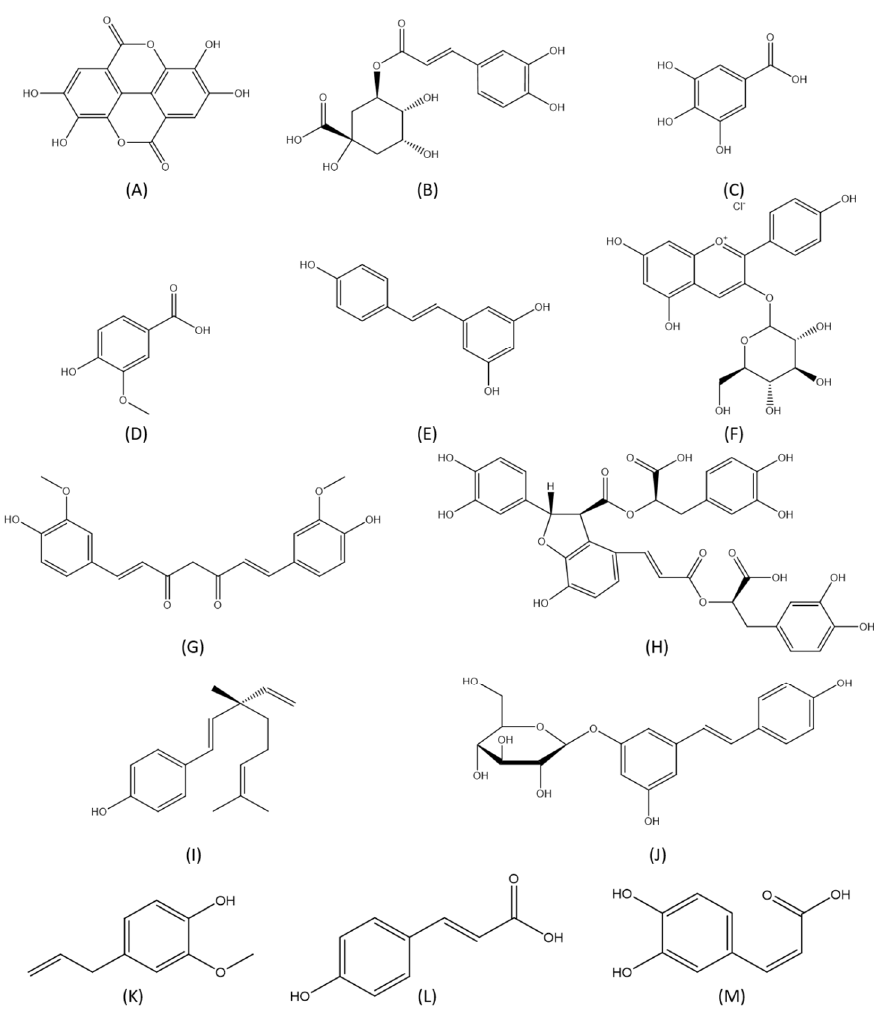
Figure 3. Chemical structures of polyphenols with potential preventive effects for aucte kidney injury. ( A ) Ellagic acid; ( B ) Chlorogenic acid; ( C ) Gallic acid; ( D ) Vanillic acid; ( E ) Resveratrol; ( F ) Anthocyanin; ( G ) Curcumin; ( H ) Salvianolic Acid B; ( I ) Bakuchiol; ( J ) Polydatin; ( K ) Eugenol; ( L ) p ‐ Coumaric acid; ( M ) Caffeic acid.